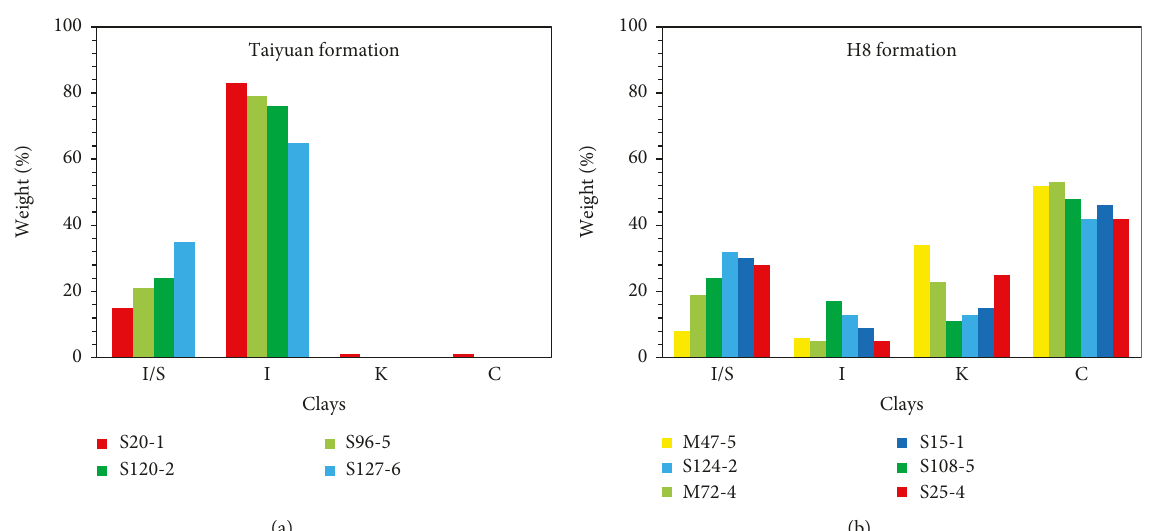
Figure 5: The content of di ff erent clays: (a) Taiyuan formation; (b) H8